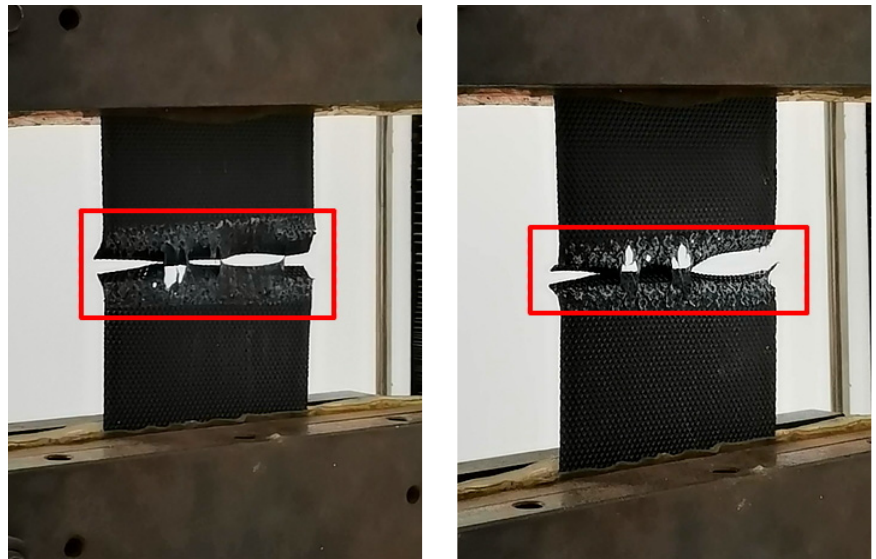
Figure 15. Weld fracture of the junction subjected to a peeling force.